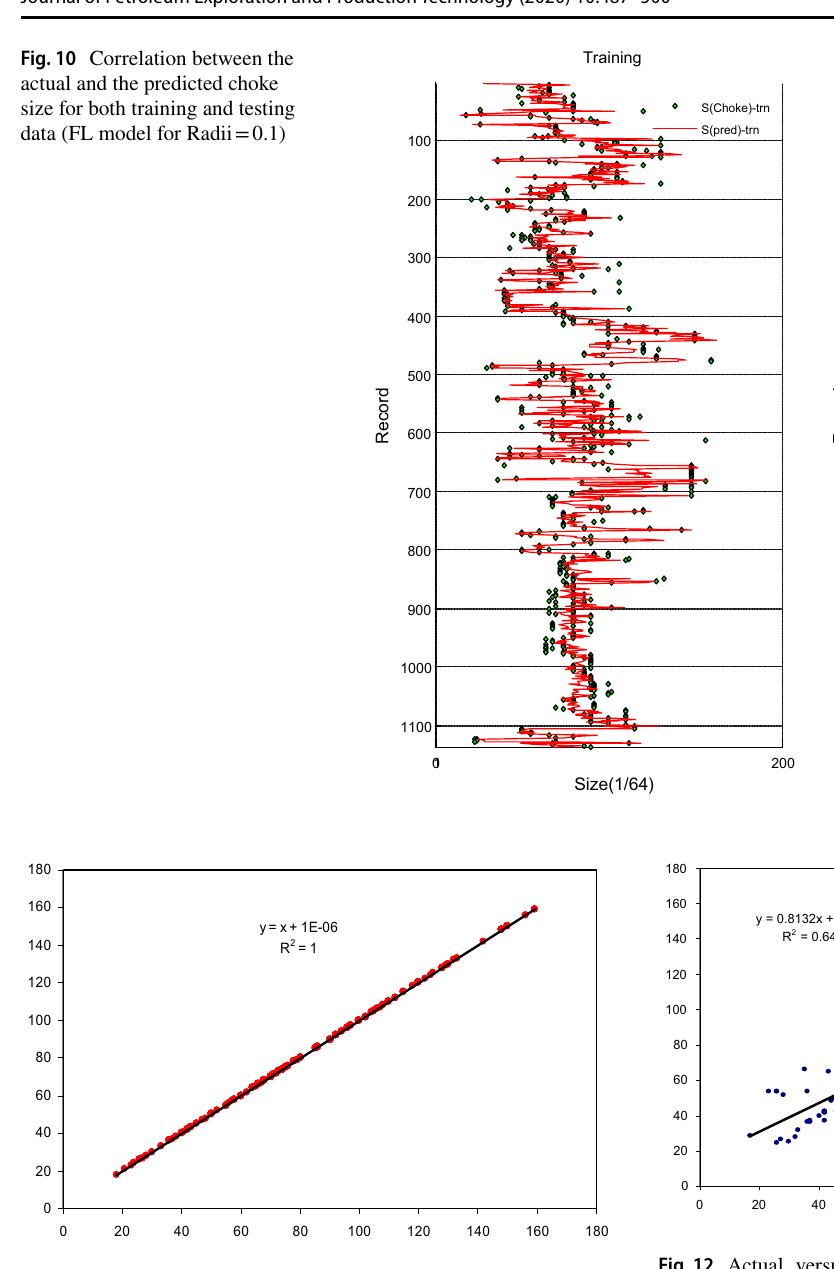
Fig. 11 Actual versus predicted choke size for FL model training (Radii = 0.01)